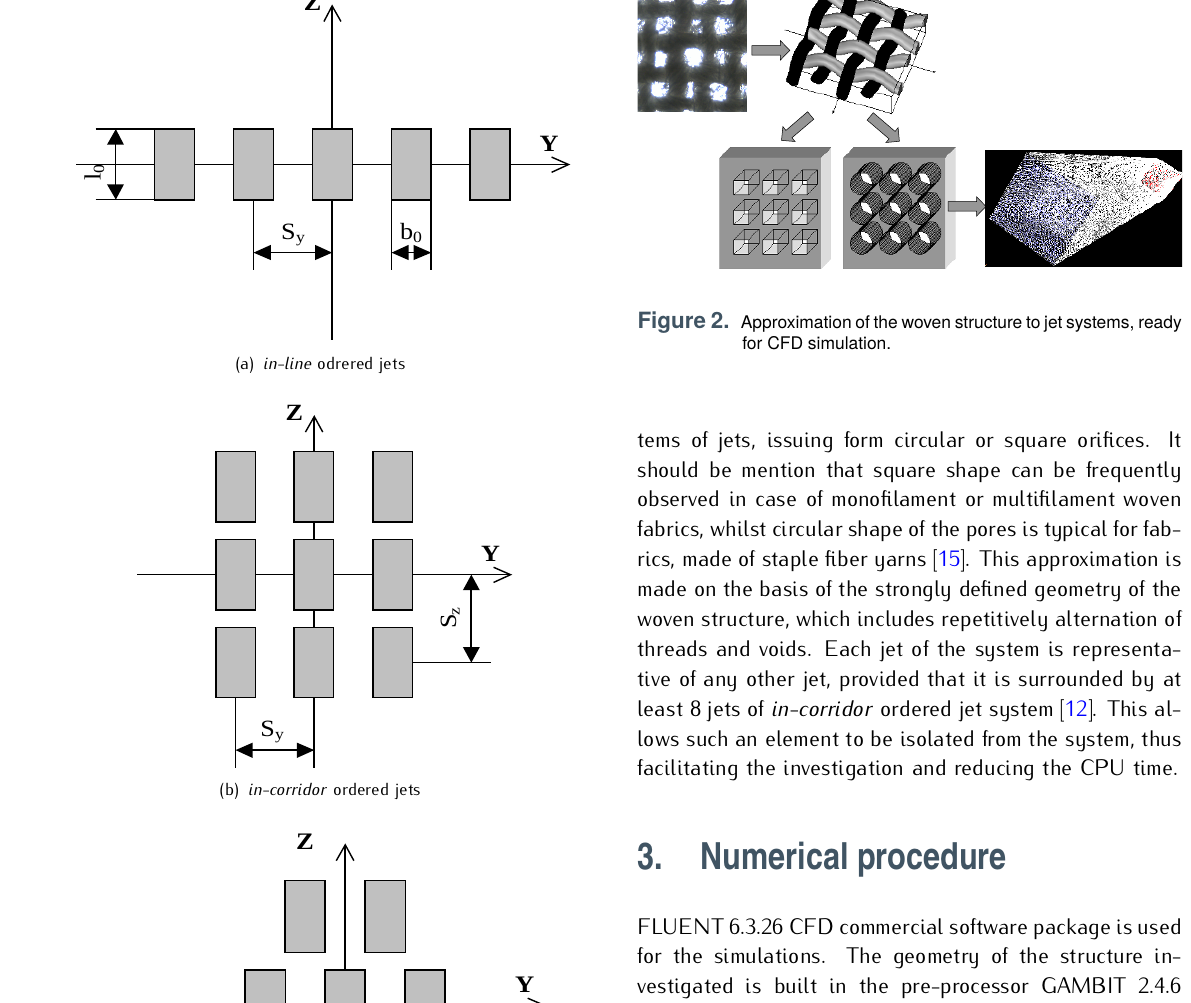
Figure 1. Types of jet systems with rectangular geometry [12]